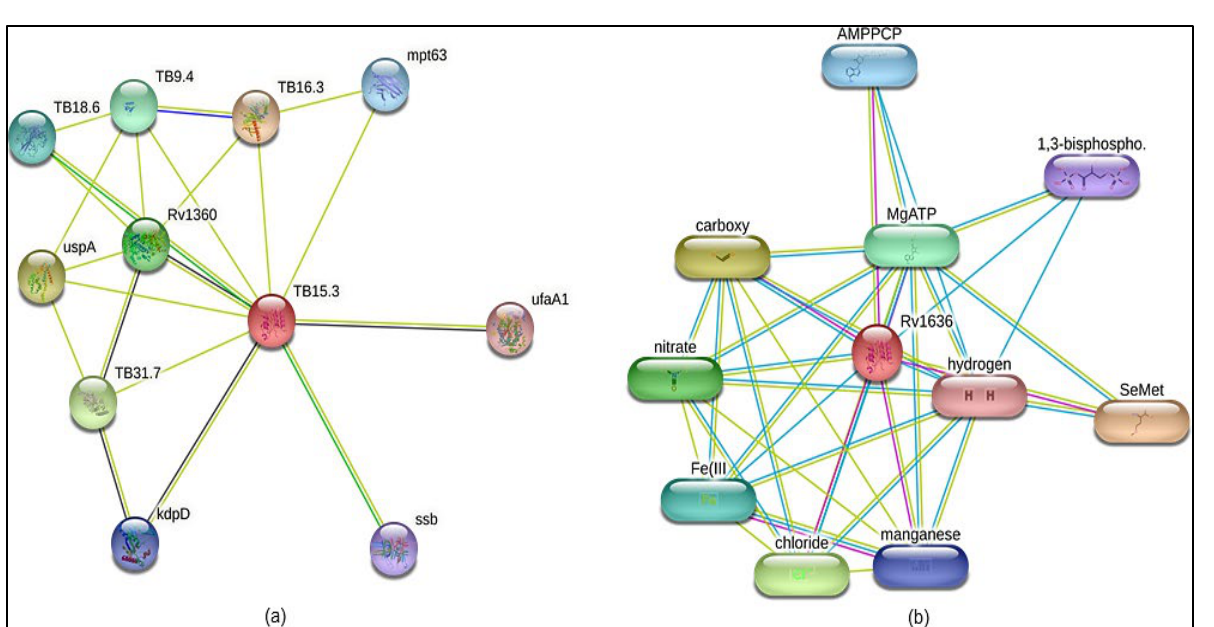
Figure 2. The interaction studies of Rv1636 protein. ( a ) Protein–protein interaction network and ( b ) protein–chemical interaction network.